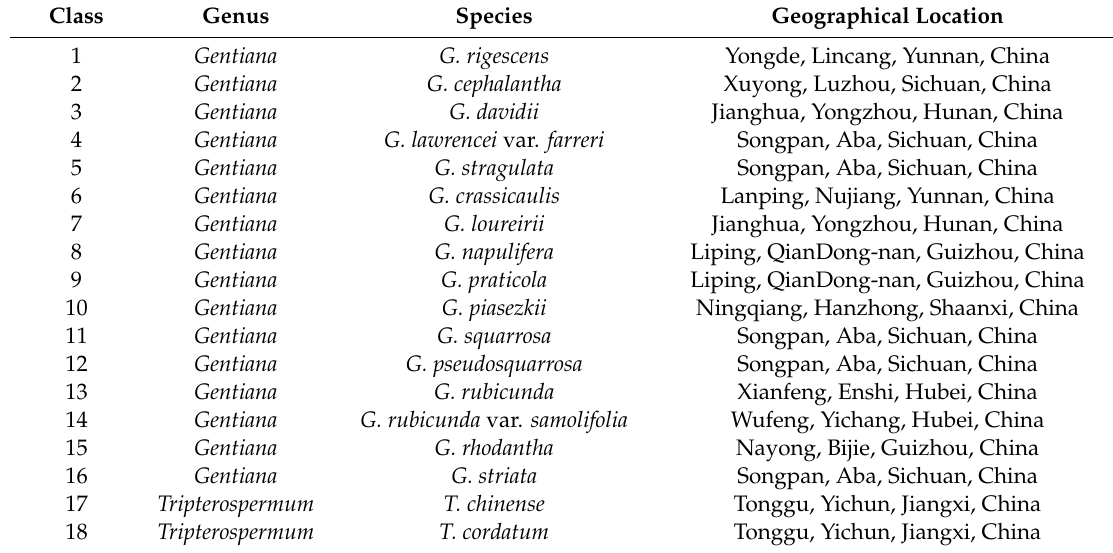
Table 11. Source of 180 Gentian and Tripterospermum species samples.